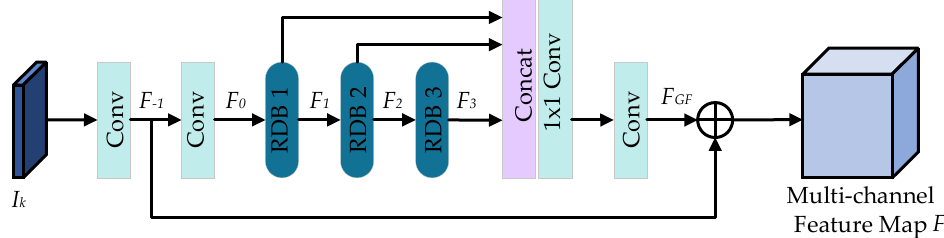
Figure 2. Network structure. The legend in the upper right corner represents a simple description of the different colored modules in the network. RDB represent residual dense block in RDN [46]. CAM and SAM represent the channel attention module and spatial attention module in CBAM [54], respectively. Conv layer represents different convolutional layers in blocks. AP layer and FC layer represent the average pooling layer and fully connected layer in ResNet-34 [55], respectively.